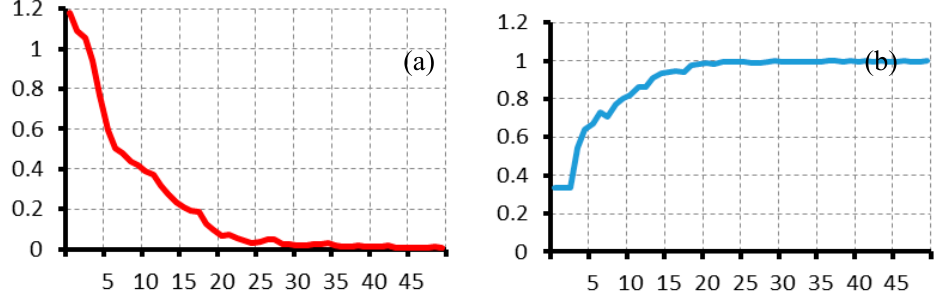
Figure 16. ( a ) Loss function value curves and ( b ) Accuracy rate curves during the training process of the proposed model.